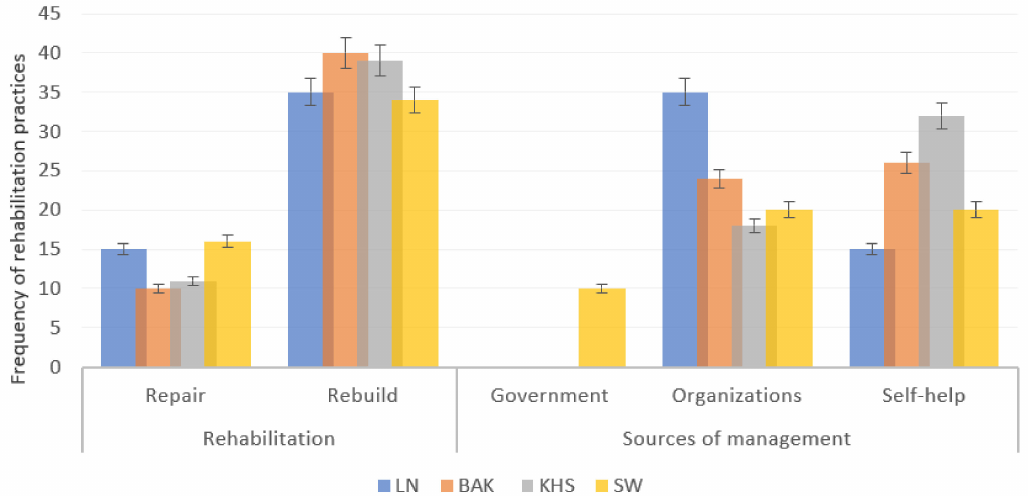
Figure 7. Rehabilitation practices and sources in flood-affected